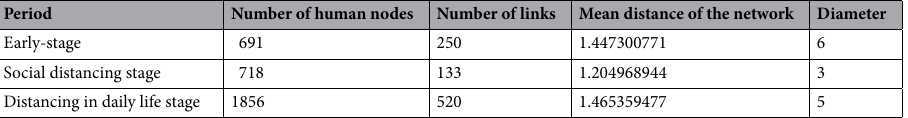
Table 2. Network indicators by period.